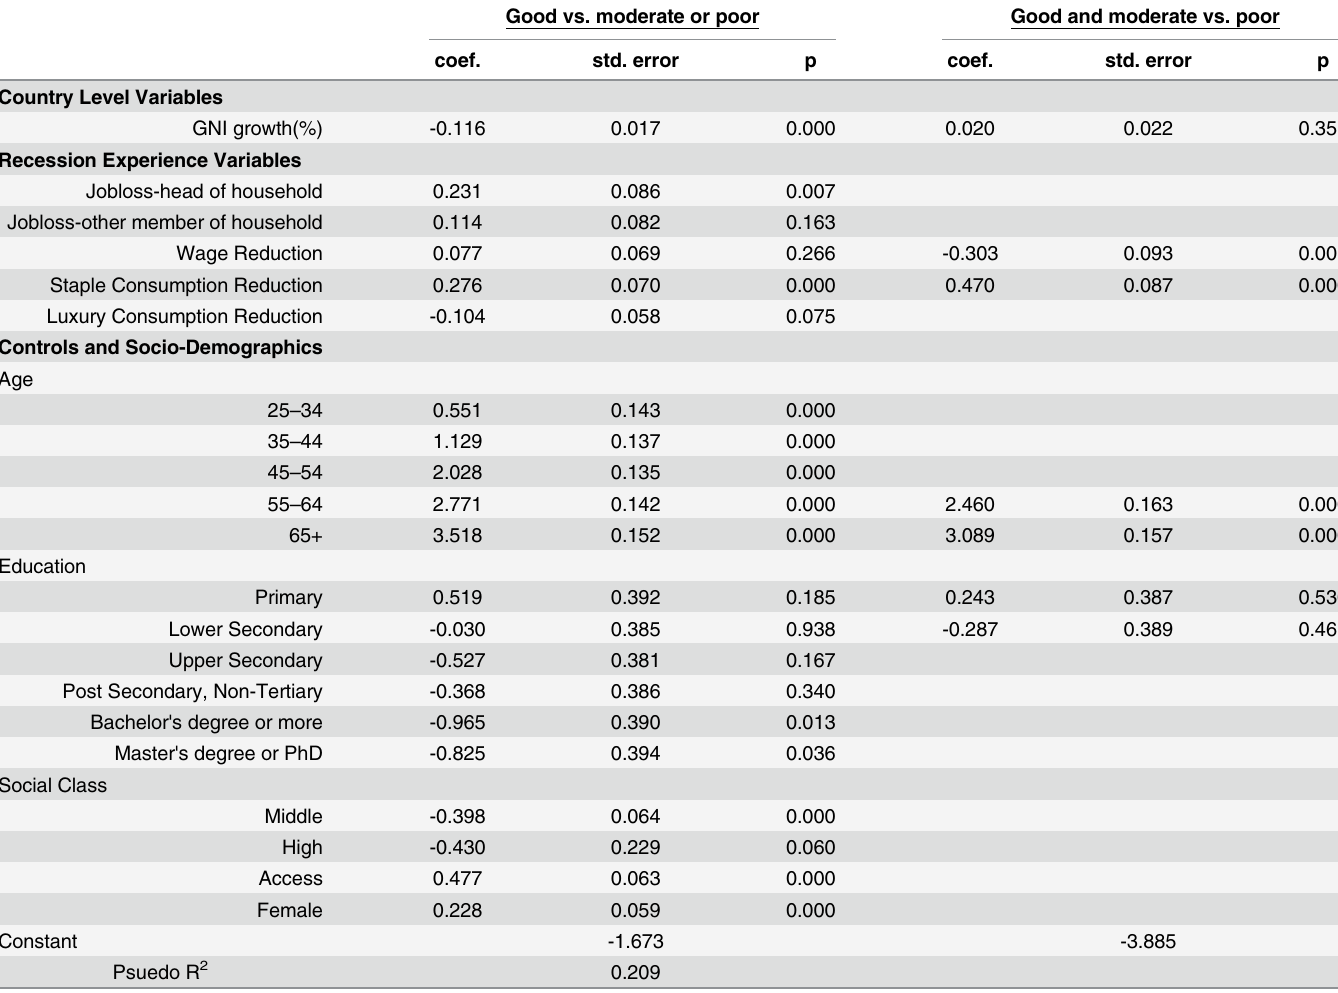
Table 8. Weighed Partial Proportion Odds Model of Self-Rated Health, third GNI per capita quartile ($12,330-$18,450). Good vs. moderate or poor Good and moderate vs. poor